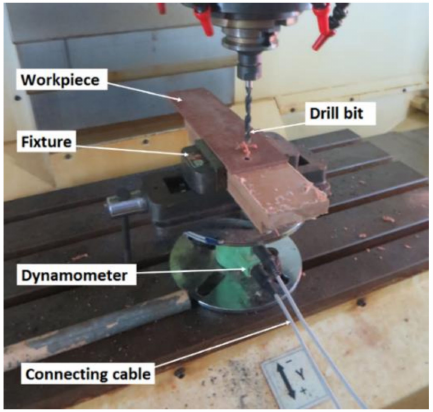
Figure 1. A typical structural component composite sample during the drilling